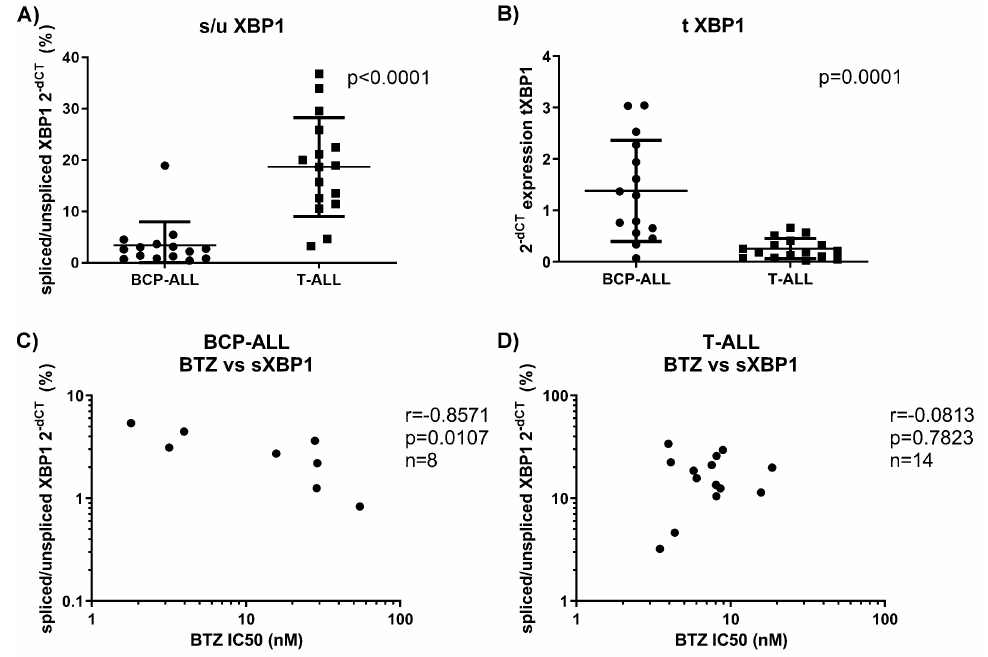
Figure 4. XBP1 transcripts in BCP-ALL and T-ALL. ( A ) s/uXBP1 determined by qRT-PCR in BCP-ALL and T-ALL. Data represent mean ± SD. p was obtained with Mann–Whitney U test. ( B ) Total variant of XBP1 determined by qRT-PCR. Data represent mean ± SD. p was obtained with Mann–Whitney U test. ( C ) Correlation between s/u XBP1 ratio and BTZ cytotoxicity in BCP-ALL. r and p were obtained with Spearman’s correlation. ( D ) Correlation between s/u XBP1 ratio and BTZ cytotoxicity in T-ALL. r and p were obtained with Spearman’s correlation. BTZ = bortezomib, s/uXBP1 = ratio of spliced vs. unspliced variants of XBP1, tXBP1 = total variant of XBP1 transcript, qRT-PCR = quantitative real-time PCR, BCP-ALL = B-cell precursor acute lymphoblastic leukemia, T-ALL = T-lineage acute lymphoblastic